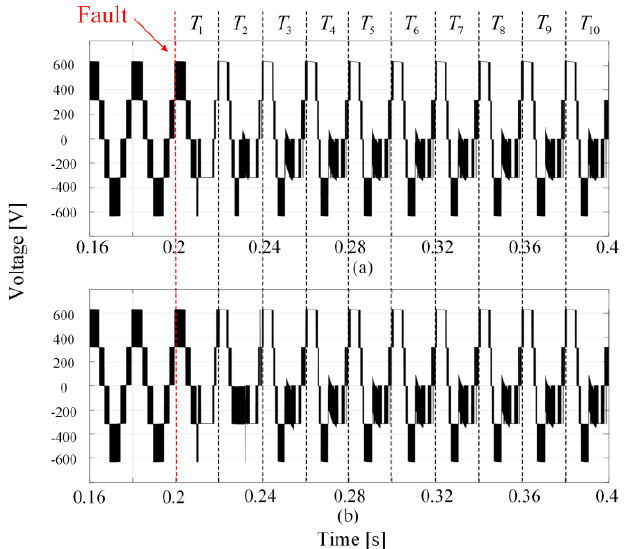
Figure 4. Inverter output voltage waveforms over 10 periods for S 2 and S 3 open-circuit faults at 0.2s under condition 1. ( a ) Switch S 2 open-circuit fault; ( b ) Switch S 3 open-circuit fault.